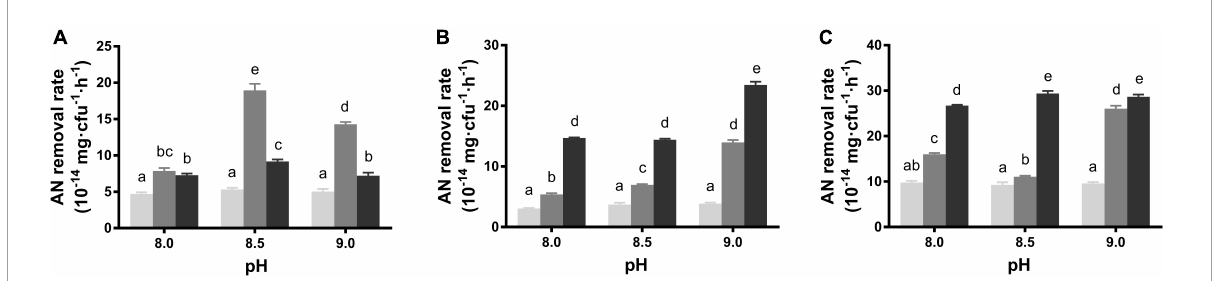
FIGURE1 AN removal rate under alkali pH and low initial AN concentrations. The removal rates in different conditions of B. idriensis CT-WN-B3 (A) , B. australimaris CT-WL5-10 (B) , and P. oleovorans CT-WL5-6 (C) were shown, and values with different superscripts were significantly different ( P < 0.05). In (A–C) , columns in light gray, dark gray, and black color, respectively, represent 1, 2, and 3 mg/L initial AN concentration group.